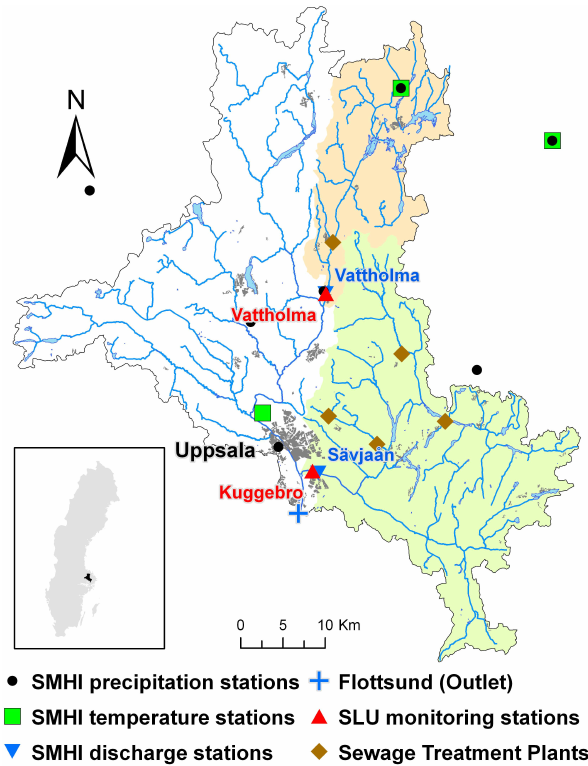
Fig. 1. The River Fyris catchment (Vattholma and S¨avja sub- catchments are highlighted in light-brown and light-green respec- tively). The names of the discharge and monitoring stations are written next to their location in blue and red,